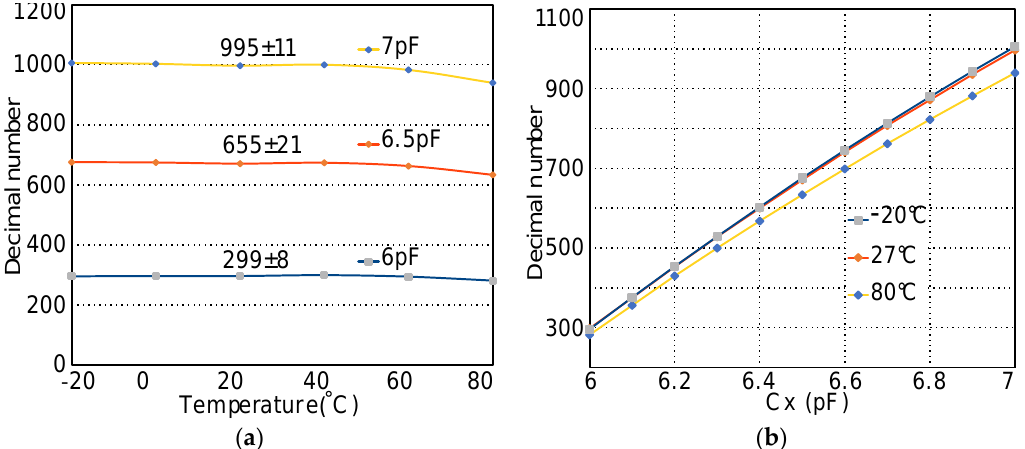
Figure 22. Post layout simulation of C-D digital output. ( a ) Digital output versus temperature with Cx = 6, 6.5, and 7 pF. ( b ) Digital output versus capacitance change with temperature of −20, 27, and 80 °C.